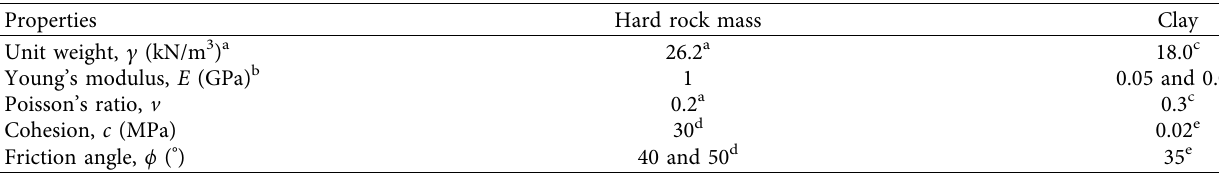
Figure 8: (a) Geological cross section along the line V33 in Figure 1 and (b) entire analytical model of the quarry. Simulated results of induced displacement in the blue rectangle are shown. Table 1: Mechanical properties of the rock materials.